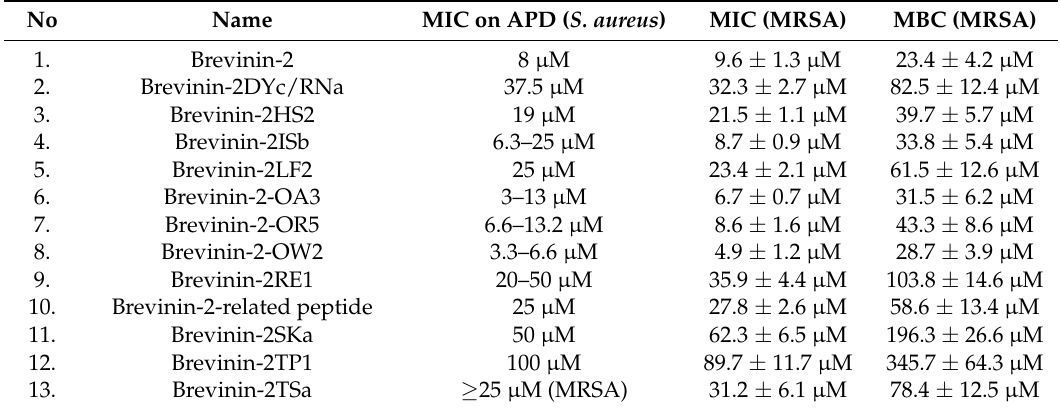
Table 3. In vitro minimum inhibitory concentration (MIC) and minimum bactericidal